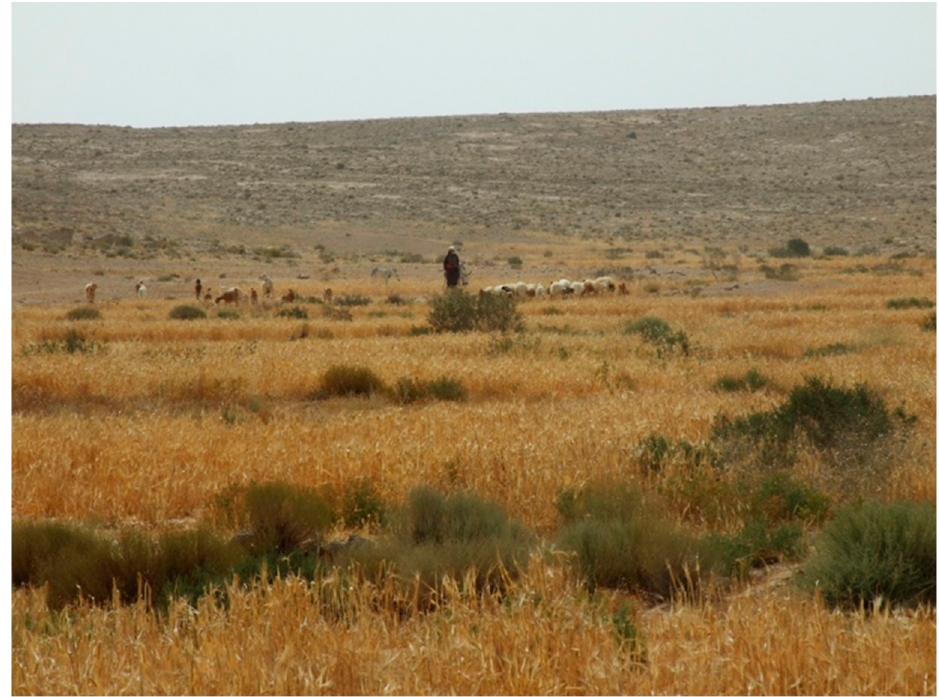
Figure 11. Present barley cultivation in the Negev Highlands, utilizing ancient Type A terraces. (Photograph: Y. Avni).